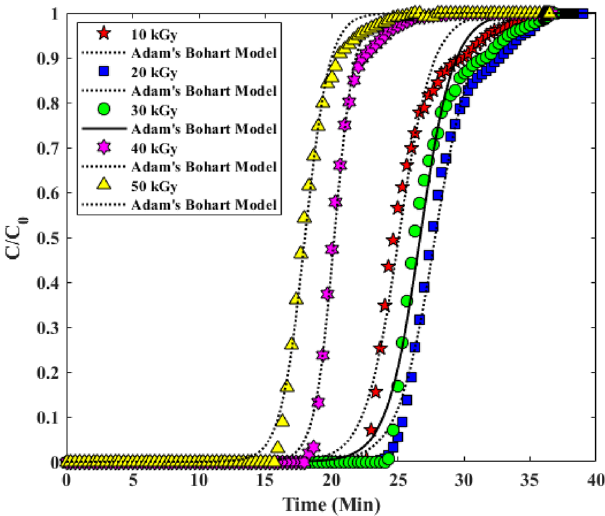
Figure 13. Investigation of Experimental Breakthrough curves in columns with Adams-Bohart model.